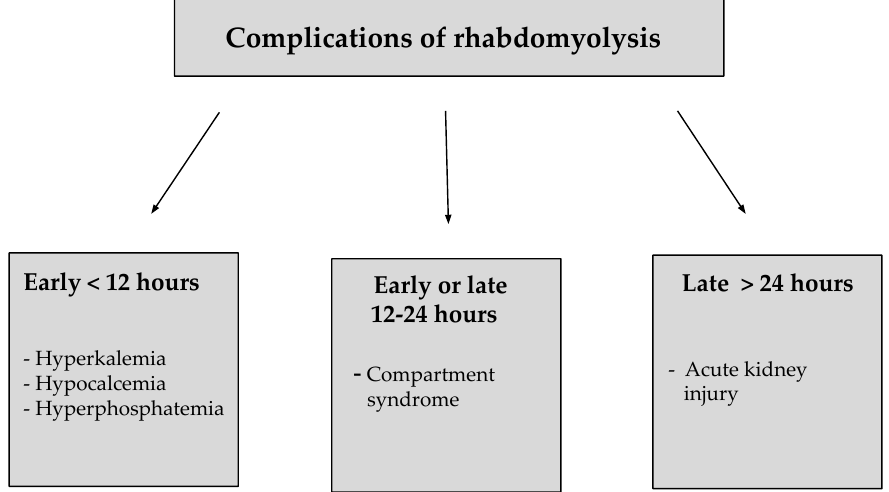
Figure 2. Classification of complications of rhabdomyolysis according to time criteria